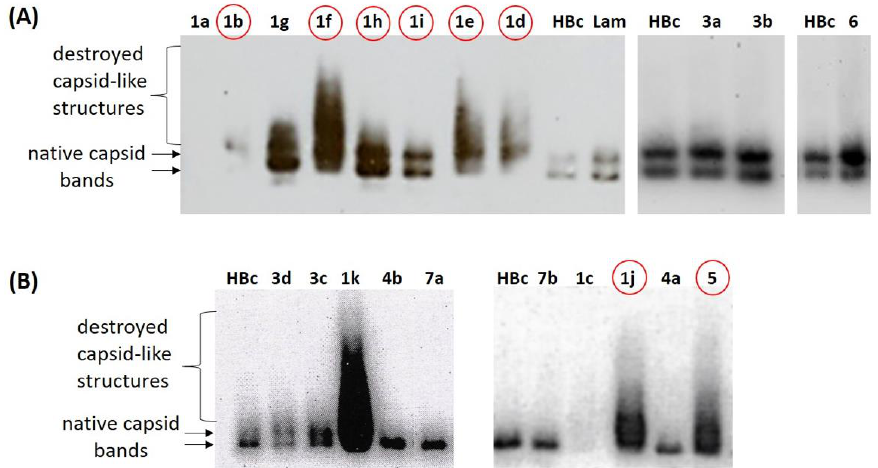
Figure 5. Analysis of the effects of HAP compounds on assembly of HBV capsids in mammalian cells. BHK-21 cells were infected with SFV1/HBc (D1 genotype) to express full-length HBc gene. After 4 h, the cell culture medium was replaced with compound-containing medium, and after 24 h of cell incubation with respective compound the medium was removed and the cell lysates were analyzed by native agarose gel electrophoresis and subsequent anti-HBc immunoblot. ( A ) Cells treated with compounds: 1a (Bay 41-4109), 10 µ M; 1b , 10 µ M; 1g , 10 µ M; 1f , 10 µ M; 1h , 10 µ M; 1i , 10 µ M; 1e , 10 µ M; 1d , 10 µ M; HBc , non-treated HBc producing BHK-21 control cells; Lam (lamivudine), 10 µ M; 3a , 20 µ M; 3b , 20 µ M; 6 , 10 µ M. ( B ) Cells treated with compounds: HBc , non-treated HBc producing BHK-21 control cells; 3d , 50 µ M; 3c , 50 µ M; 1k , 10 µ M; 4b , 50 µ M; 7a , 25 µ M; 7b , 1 µ M; 1c , 5 µ M; 1j , 5 µ M; 4a , 5 µ M; 5 , 50 µ M. Capsid bands are indicated with arrows; capsid-like structures are indicated with brace. Equal protein amount of the total cell lysates was loaded in each well of the agarose gel. Compounds selected for further dose-dependent study are indicated in red